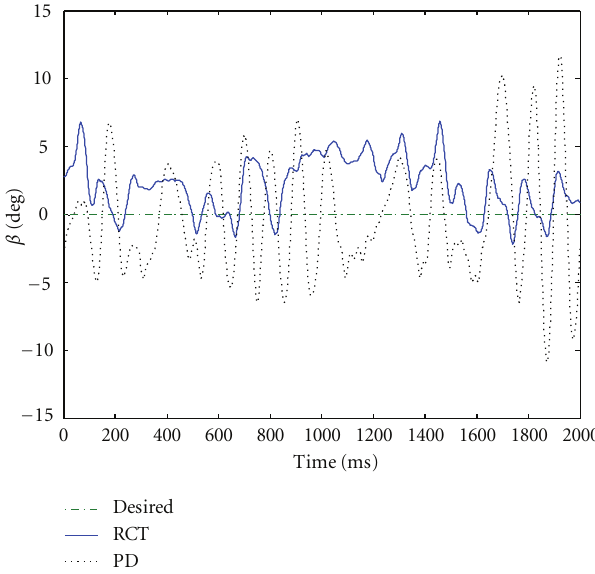
Figure 17: Lean angle comparison of PD (black dotted line) and RCT control (blue solid